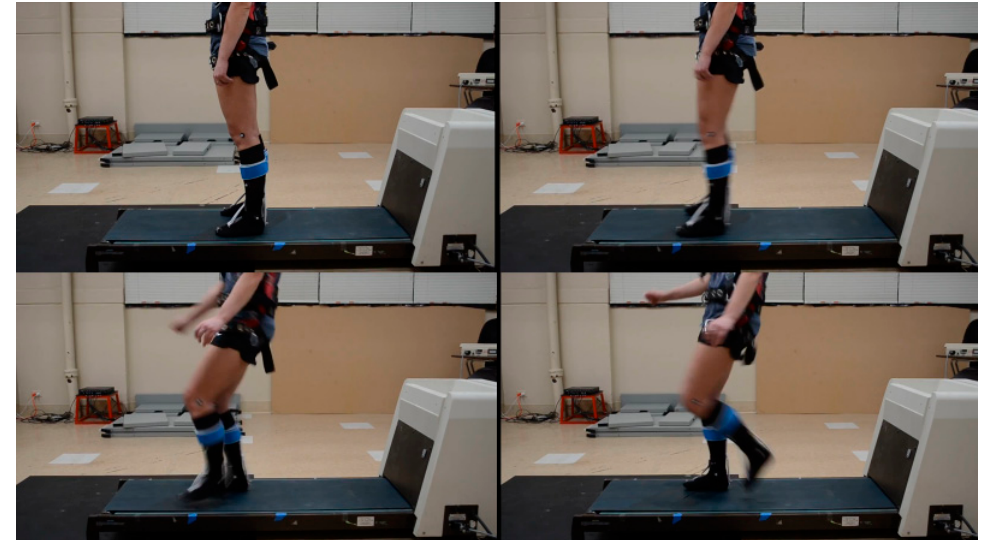
Figure 2. A sequence of an unexpected slip perturbation with wearable SRS and a motion capture marker system to assess fall